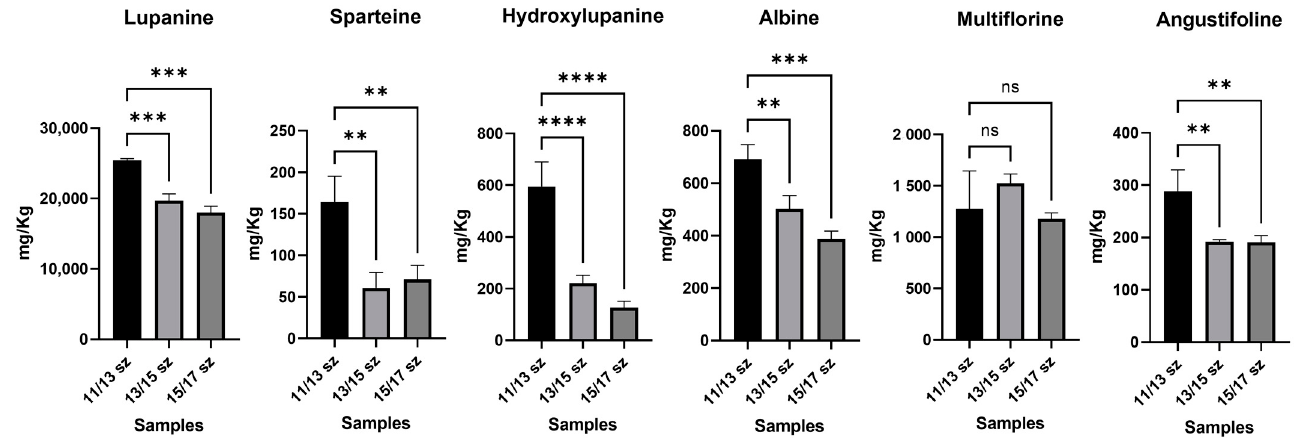
Figure 6. In these histogram plots, all 6 LAs detected in the raw lupin samples of different calibers were reported. The samples were grouped for each LA. The concentration of LAs was reported as mg Kg − 1 of sample. Y axis title = Concentration (mg Kg − 1 ). X axis title = Different caliber samples. (**) = p -value ≤ 0.01, (***) = p -value ≤ 0.005, (****) = p -value ≤ 0.001.